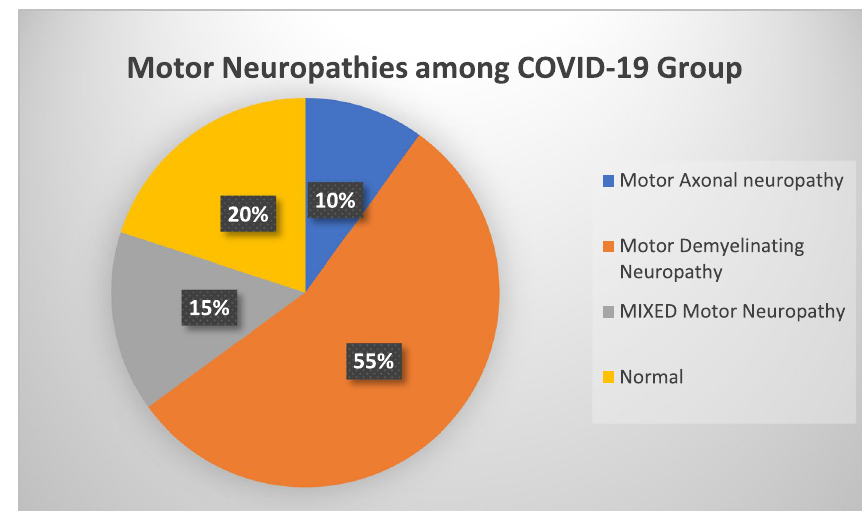
Fig. 1 Frequency and types of motor neuropathies among COVID-19 groups ( n